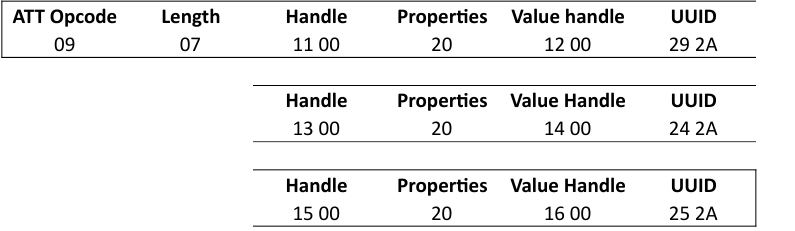
Figure 7. Characteristic discovery response.